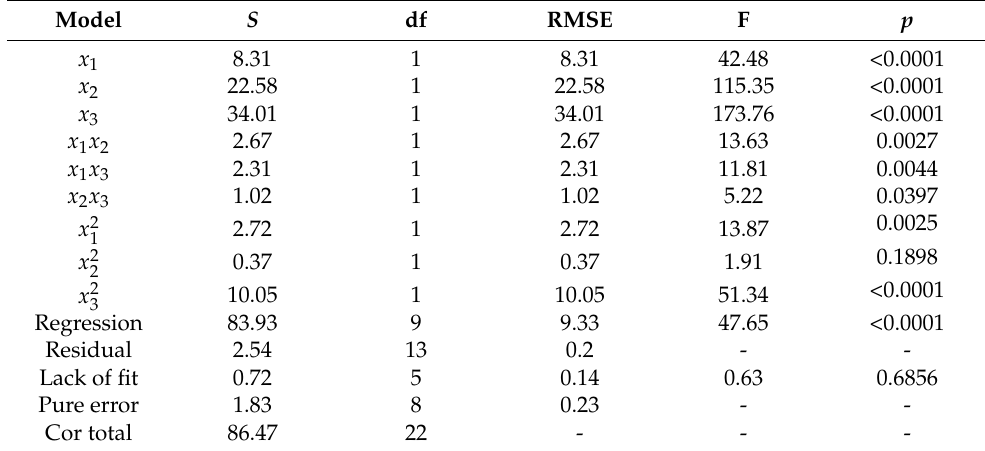
Table 6. Variance analysis of the orthogonal test